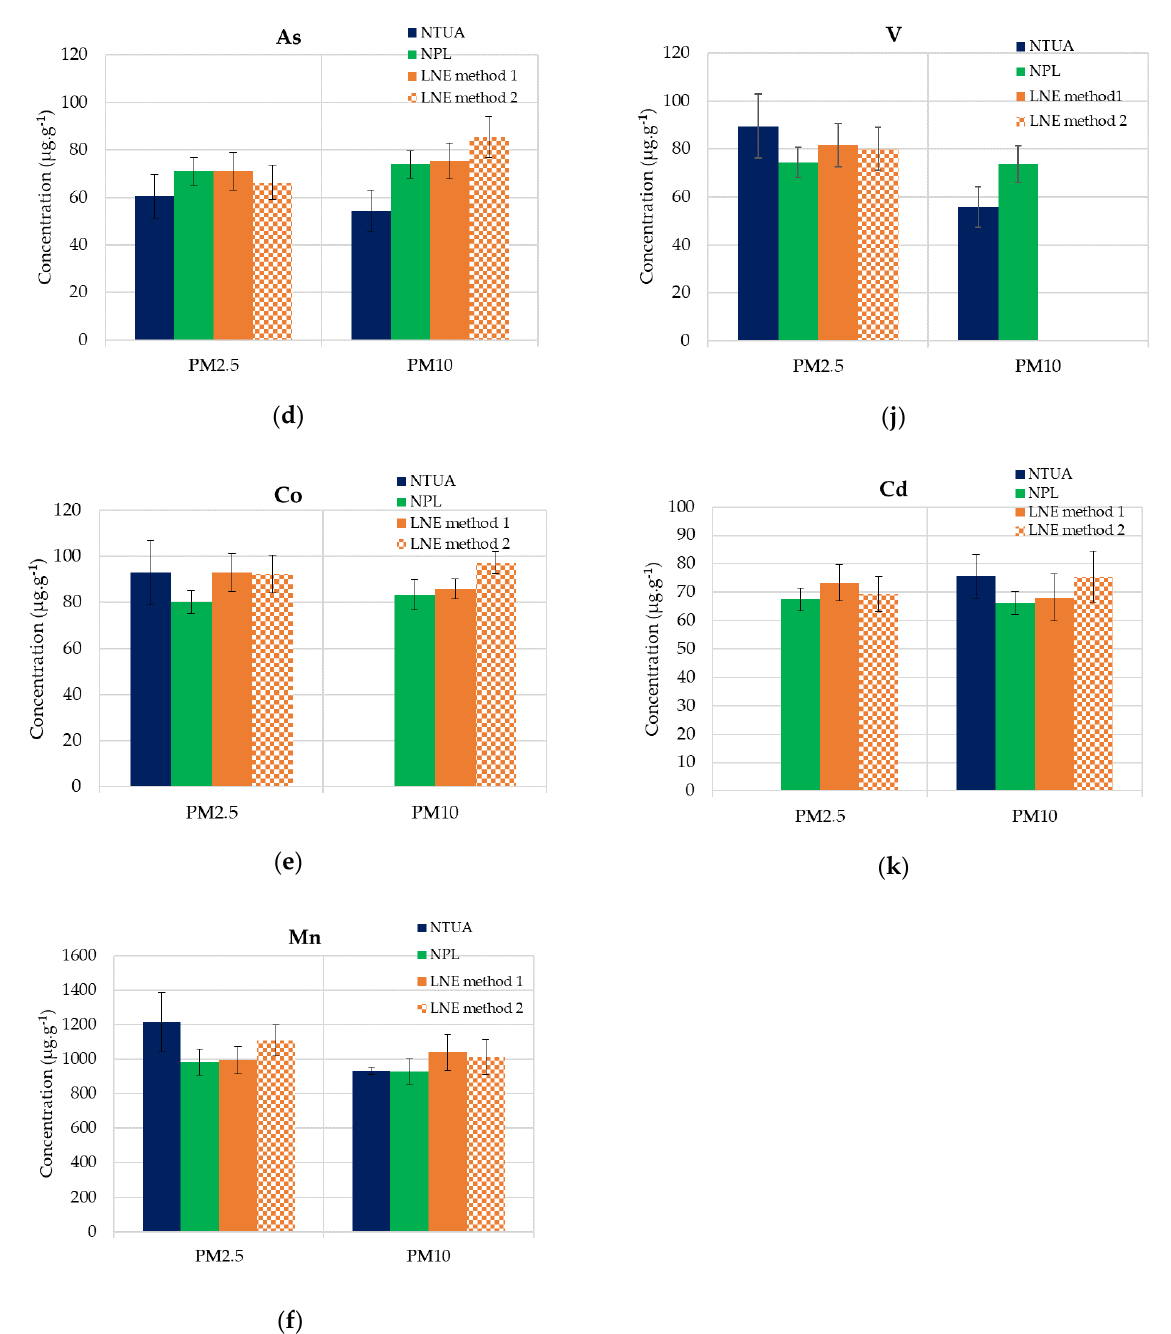
Figure 5. ICP-MS results (mean values of each lab) for PM 2.5 and PM 10 -loaded filters and mean uncertainties. ( a ) Cr, ( b ) Fe, ( c ) Cu, ( d ) As, ( e ) Co, ( f ) Mn, ( g ) Ni, ( h ) Zn, ( i ) Pb, ( j ) V and ( k ) Cd.